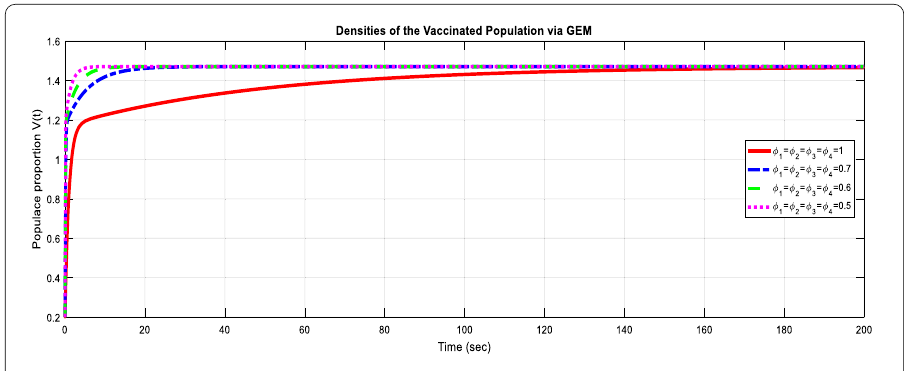
Figure 4 Dynamic of V by varying the value of φ